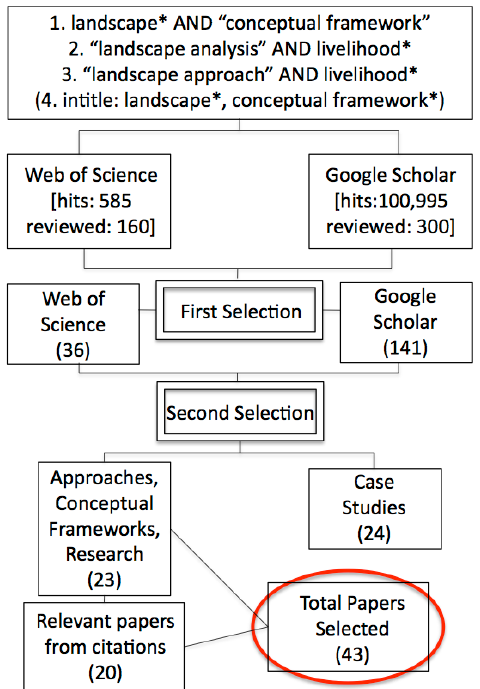
Figure A1.1 Diagram of the article selection process with the four sets of search terms, the number of hits returned from the two search sites and the number of articles selected at each stage of the process. The second and third sets of search terms contain the word ‘livelihood’, chosen to help find articles that included human systems as stipulated in the inclusion